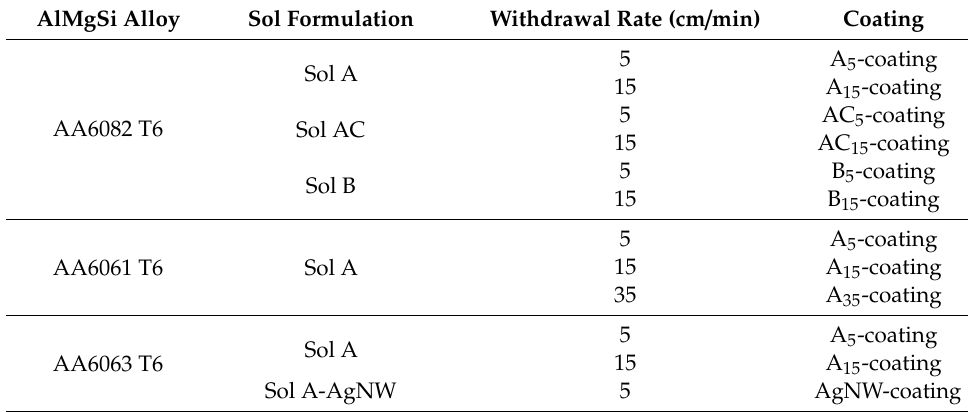
Table 3. Coatings deposited and studied on each AlMgSi